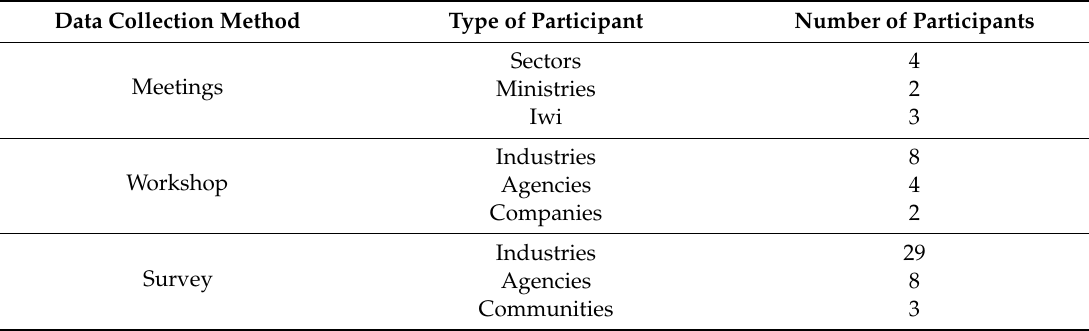
Table 2. Data collection methods, who participated and how many people were